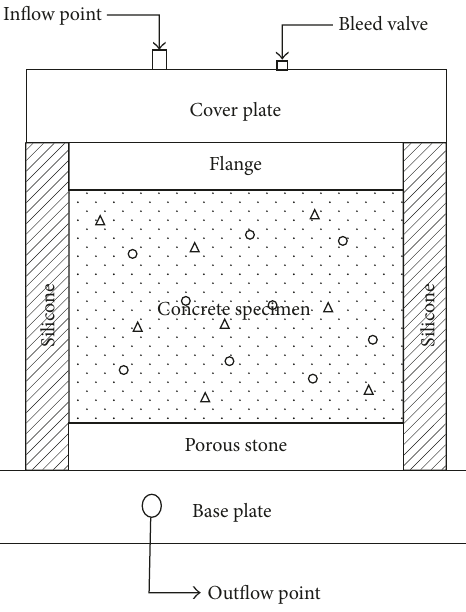
Figure 3: Setup for permeability cell.